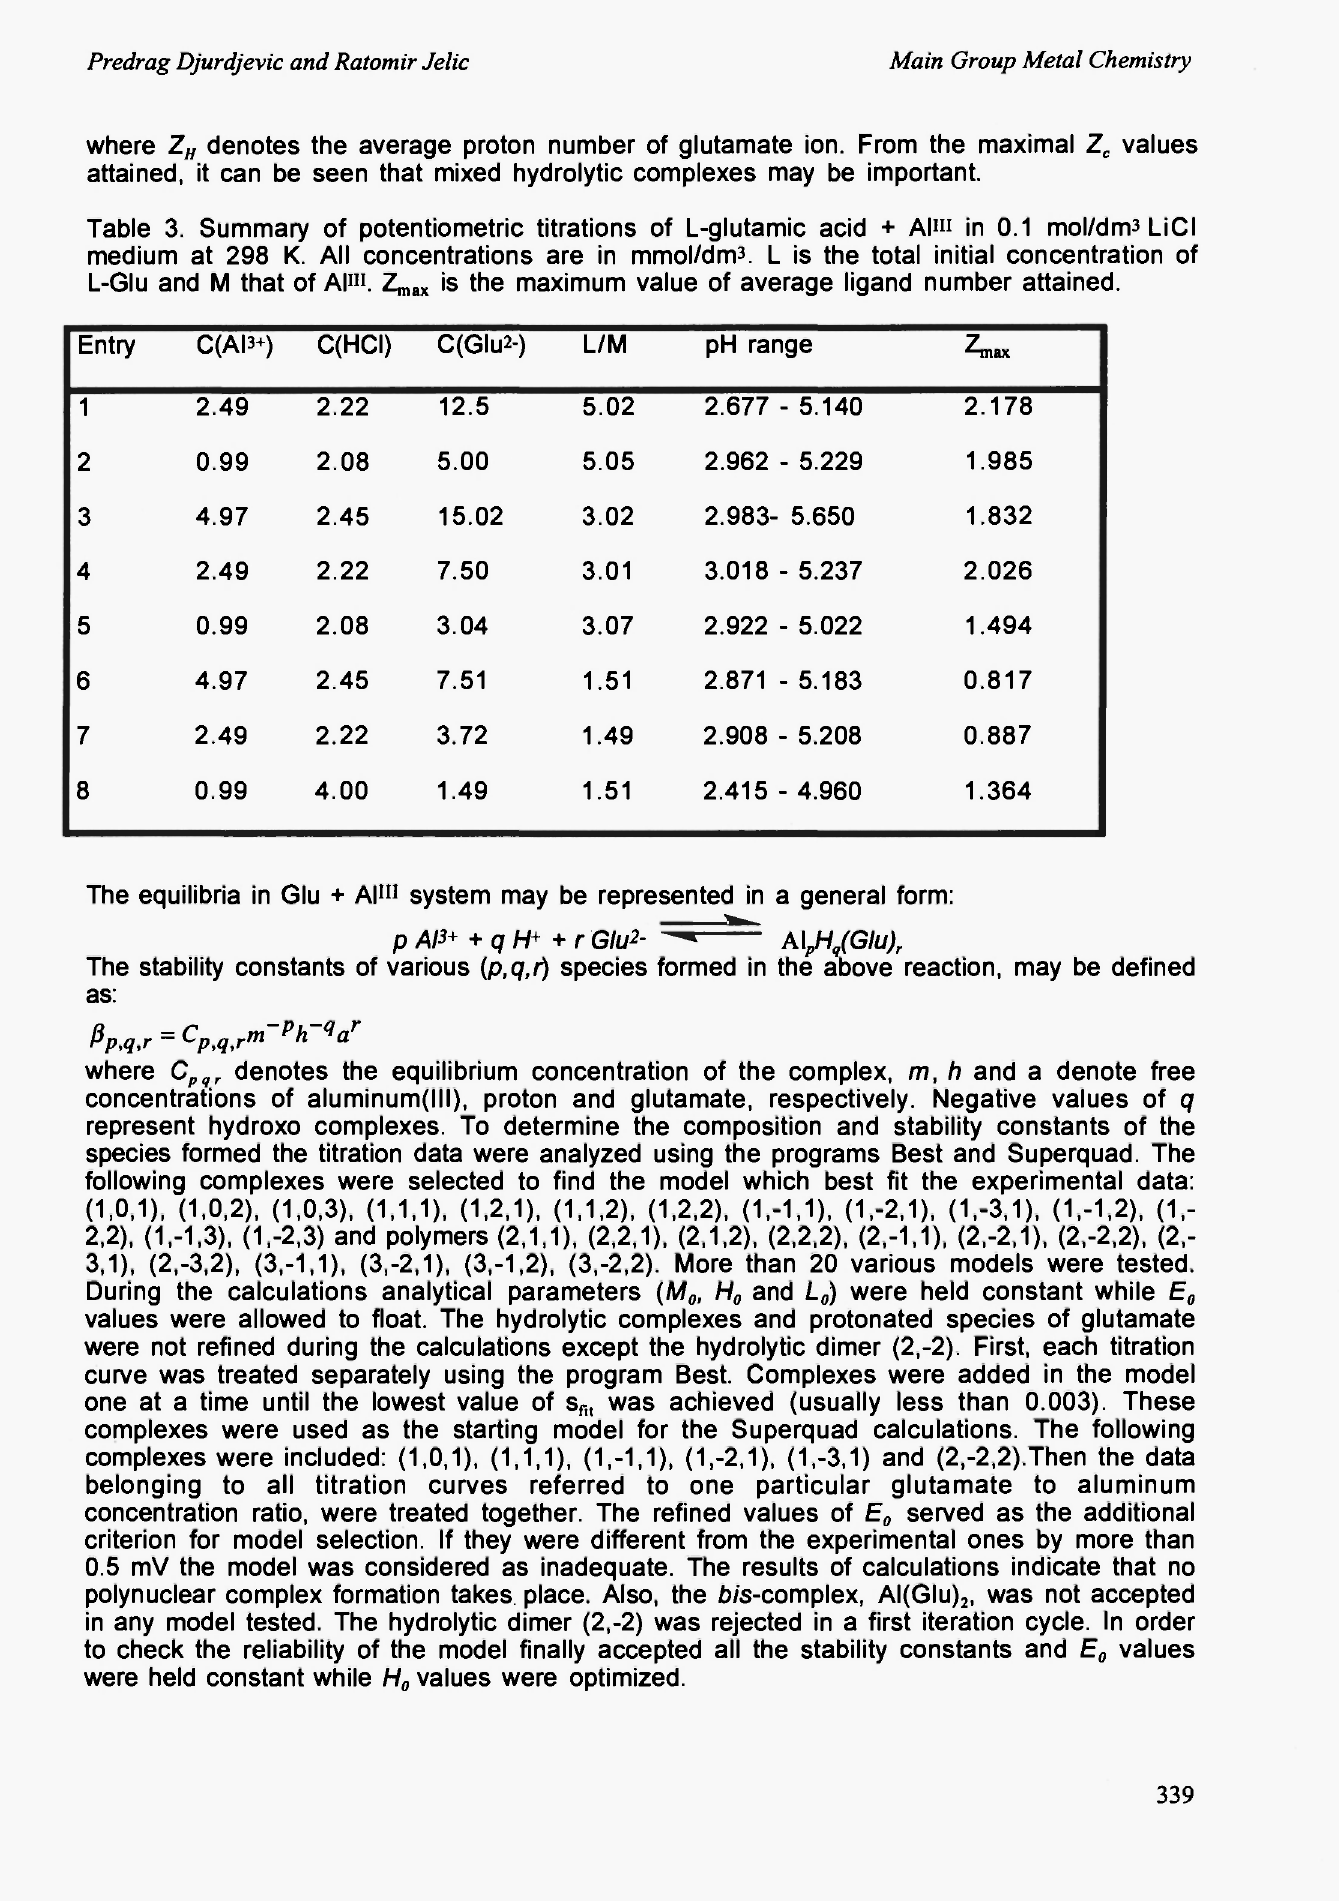
Table 3. Summary of Potentiometrie titrations of L-glutamic acid + Al»i in 0.1 mol/dm3|_iCI medium at 298 K. All concentrations are in mmol/dm^. L is the total initial concentration of L-Glu and Μ that of Al 1 ». Z„, ax is the maximum value of average ligand number